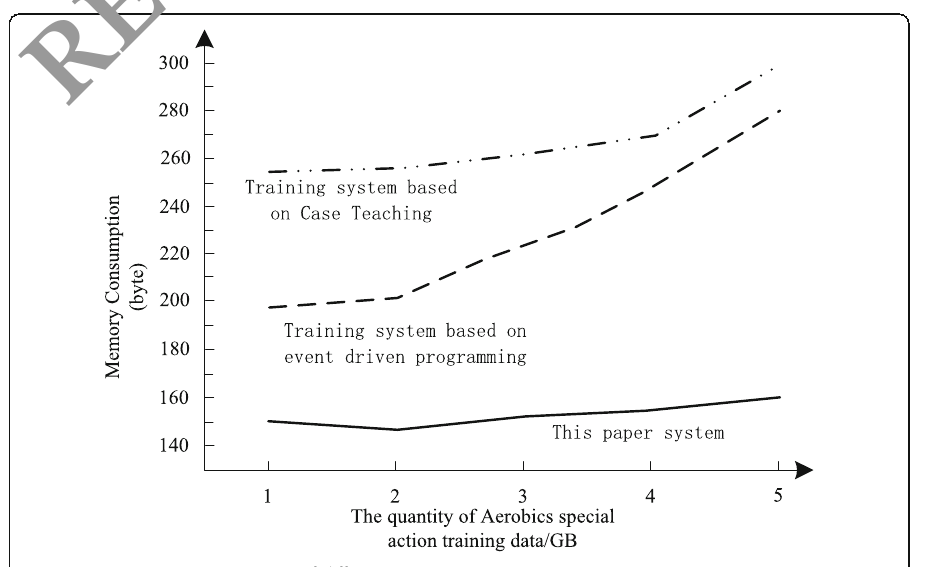
Fig. 9 Memory consumption rate of different